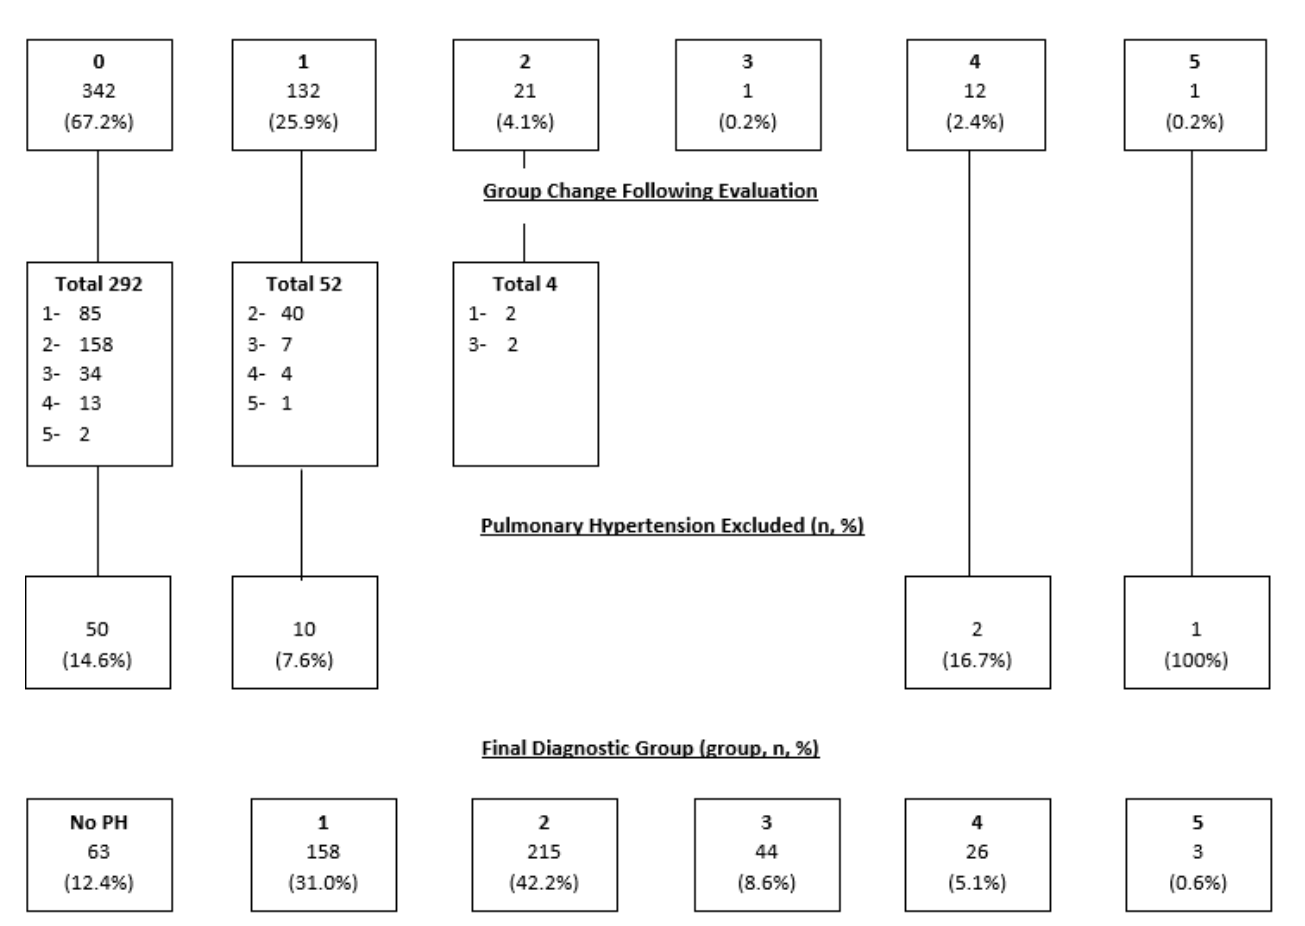
Figure 1. Diagnostic accuracy of 509 randomly selected patients beginning with the referral diagnosis, noting that 342 patients were not classified in a pulmonary hypertension diagnostic group, referred to as group “0” in the figure. The “Group Change Following Evaluation” displays a subset of referral diagnosis and the reclassification into group 1, 2, 3, 4, or 5 as determined by the guideline-based evaluation in the pulmonary hypertension clinic.